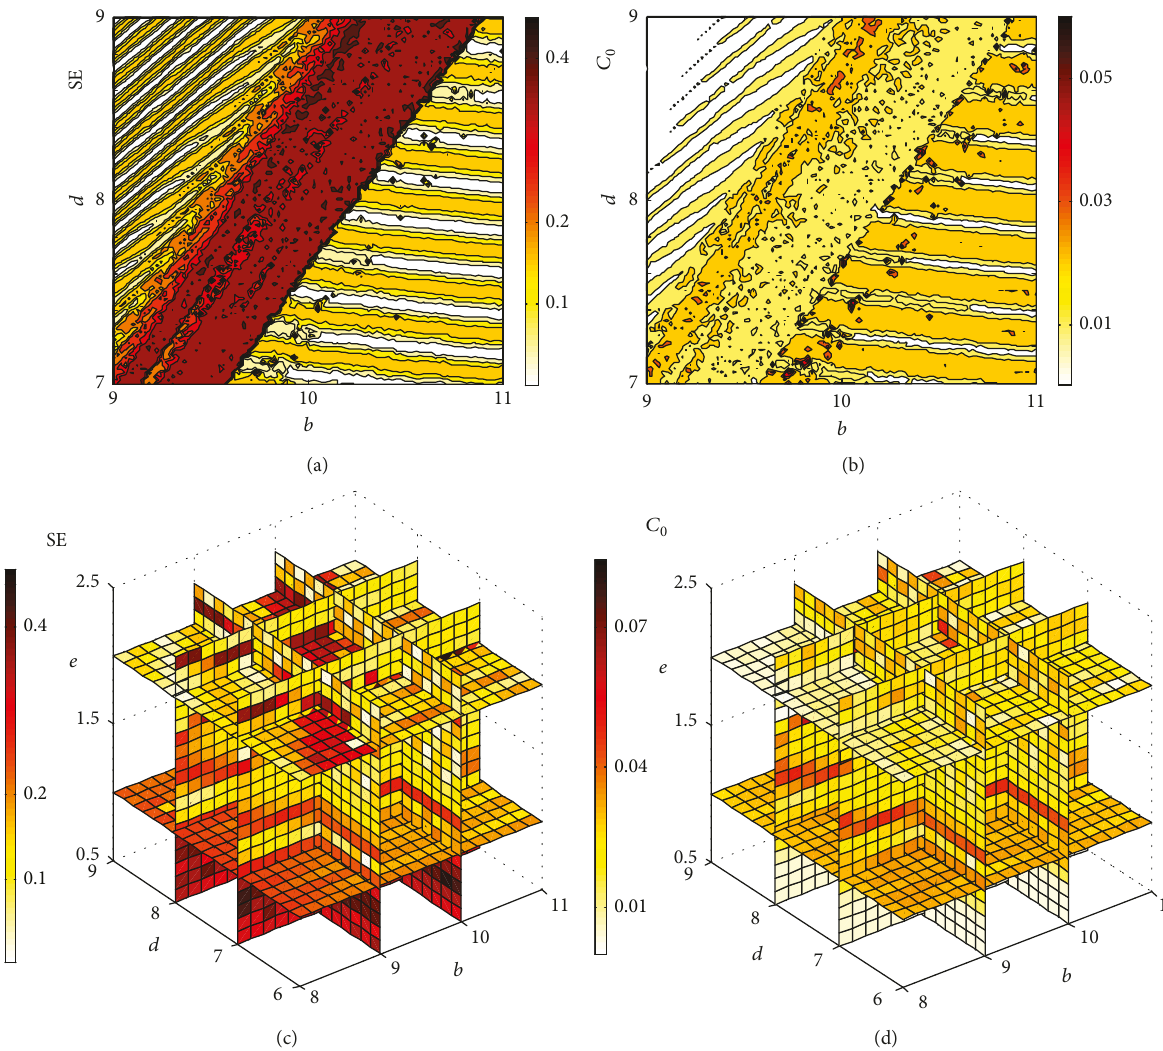
Figure 9: Complexity characteristics of the system. (a) 2D SE complexity, (b) 2D C C 0